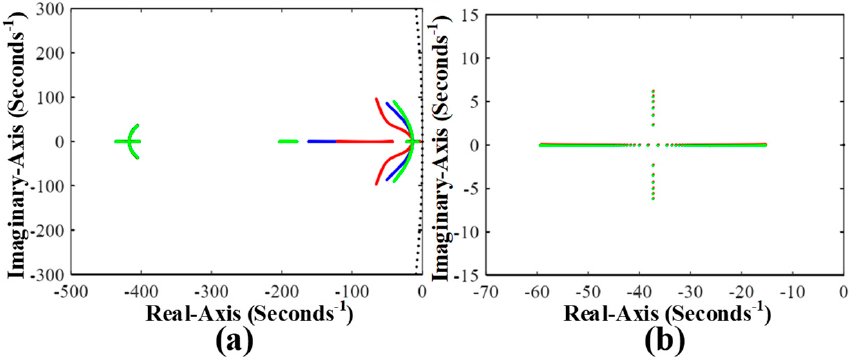
Figure 7. Pole distributions of system between different rotor resistance: ( a ) pole distribution diagram of motor before design; ( b ) pole distribution diagram of motor after design.